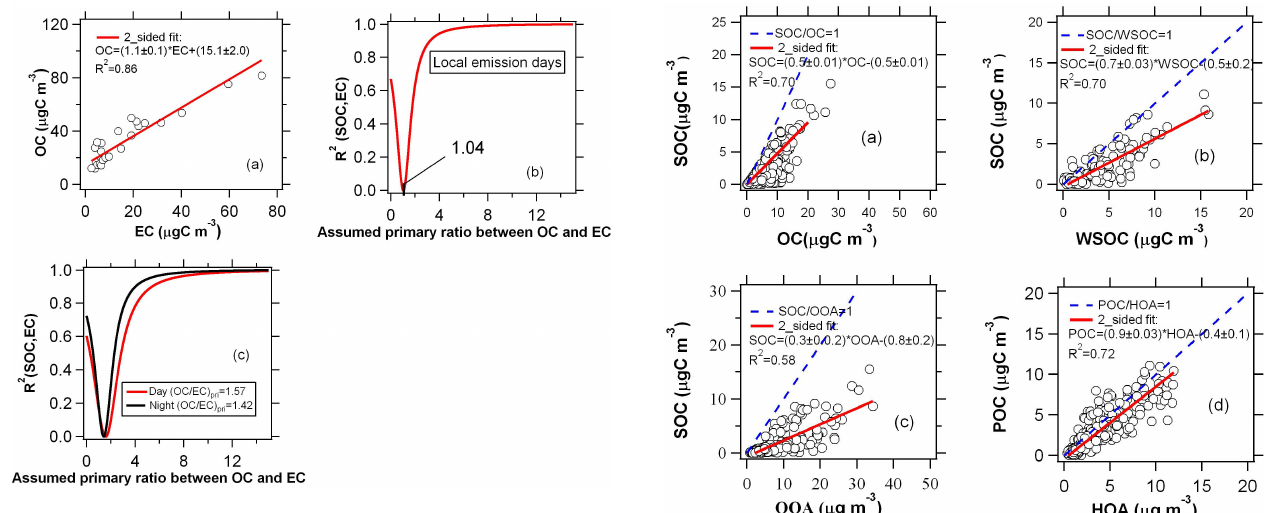
Fig. 8. Scatter plots of different organic aerosols at BG site, OC (a) ,